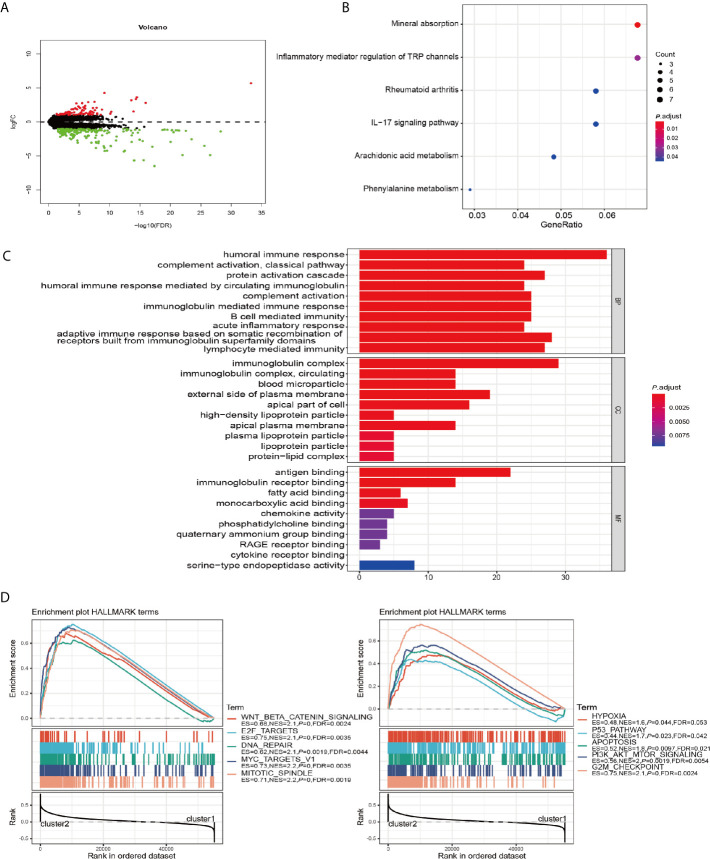
GO, KEGG, and GSEA analysis of DEGs. (A) Volcano plot showing differentially expressed genes between cluster 1 and cluster 2. (B) Functional annotation of the genes with different expression patterns between cluster 1 and cluster 2 using KEGG pathway terms. (C) Functional annotation of the genes with different expressions between cluster 1 and cluster 2 using GO terms. (D) GSEA showed that genes with higher expressions in cluster 2 were significantly enriched in hallmarks of malignant tumors.